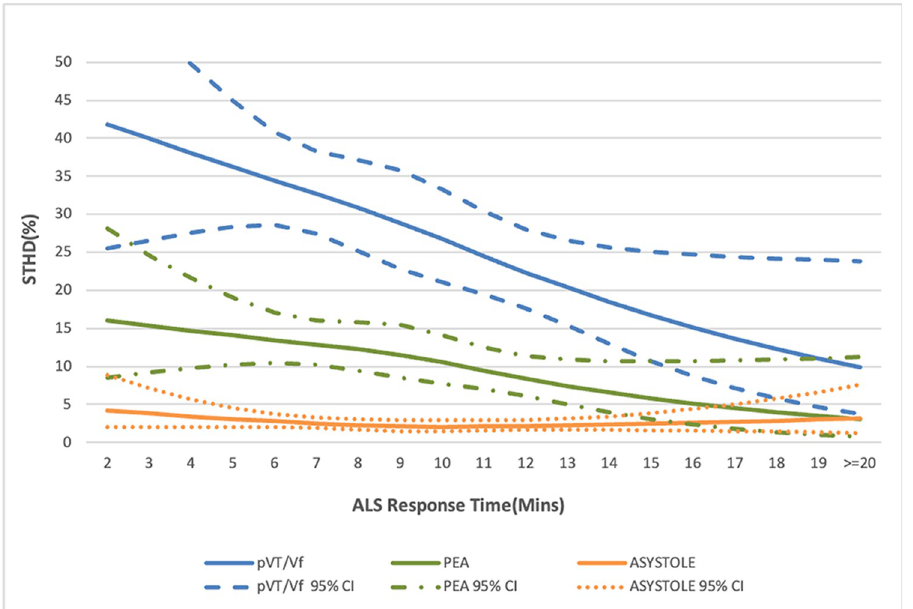
Fig 3. Restricted cubic spline curve for the survival to hospital discharge (%) and ALS response time with subgroups according to initial cardiac rhythm of the patients. Abbreviations: ALS = advanced life support. STHD = survival to hospital discharge. pVT = pulseless ventricular tachycardia. PEA = pulseless electrical activity. VF = ventricular